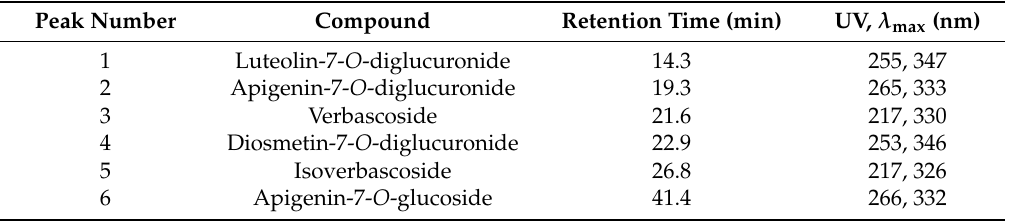
Table 1. Retention time and UV maximum absorption of major constituents from Aloysia triphylla leaves. Peak Number